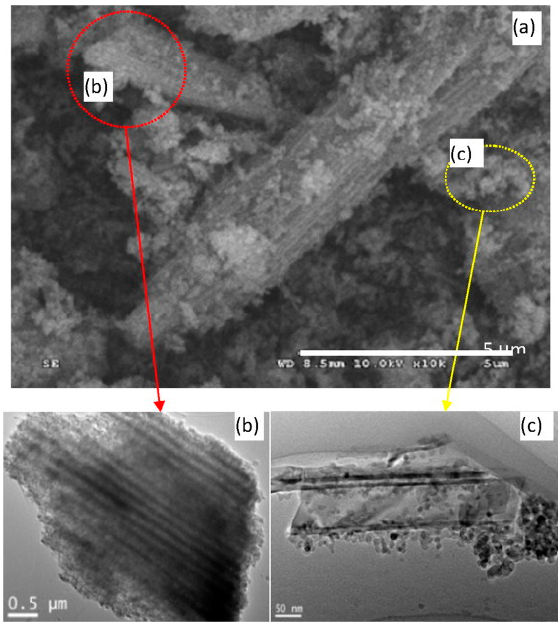
Figure 36. ( a ) SEM images of microporous TiO 2 and TEM images of ( b ) the larger particles and ( c ) the smaller aggregates shown in ( a ). Reproduced with permission from [65].